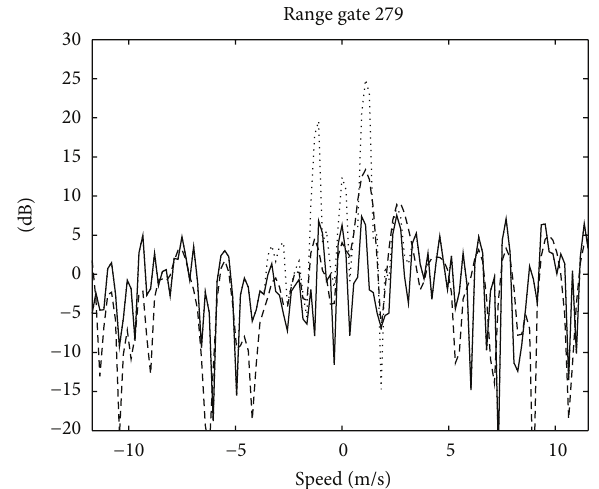
Figure 15: Comparison of classical STAP (dash curve) Stop-Band STAP (dot curve) and deterministic aided Stop-Band (solid curve) on RAMSES data for range gate number 279.